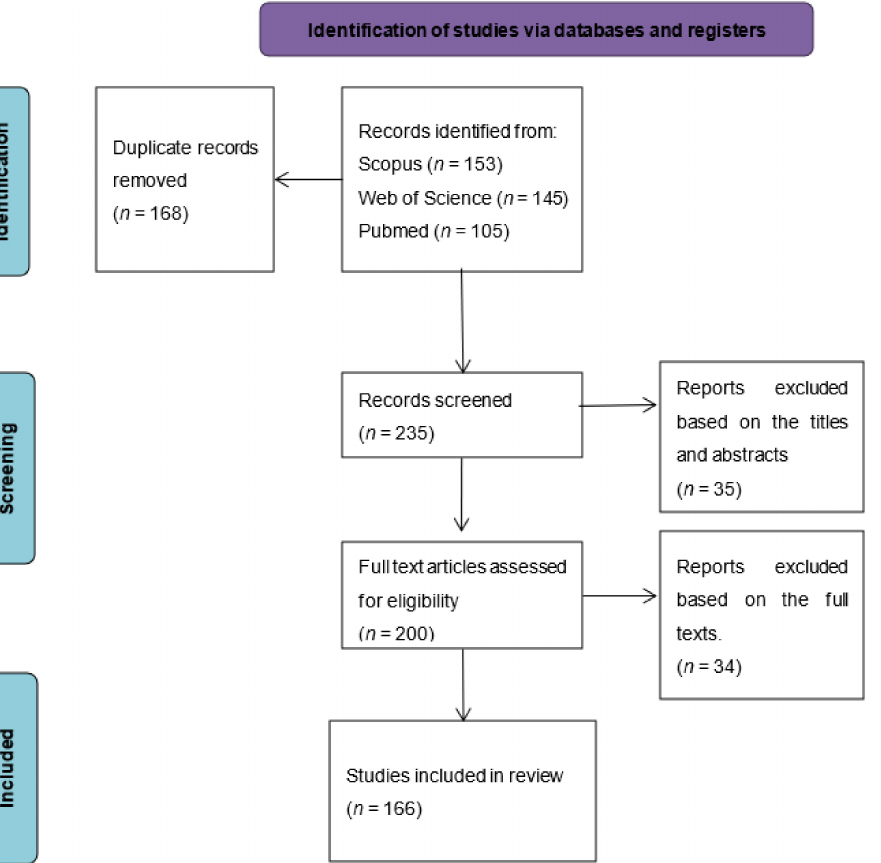
Figure 1. The flow chart of the identification and selection